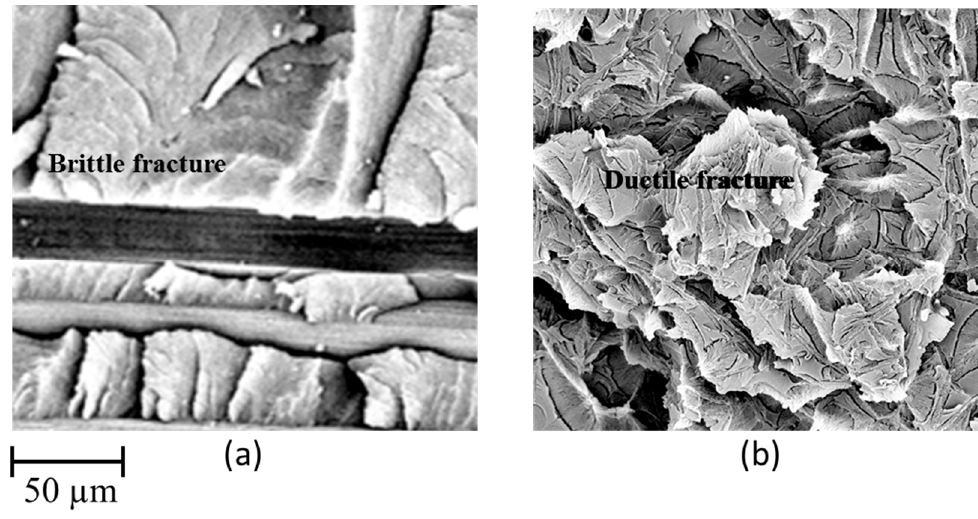
Figure 8. Different morphology of fracture surfaces in the case of: ( a ) virgin and ( b ) nano-modified